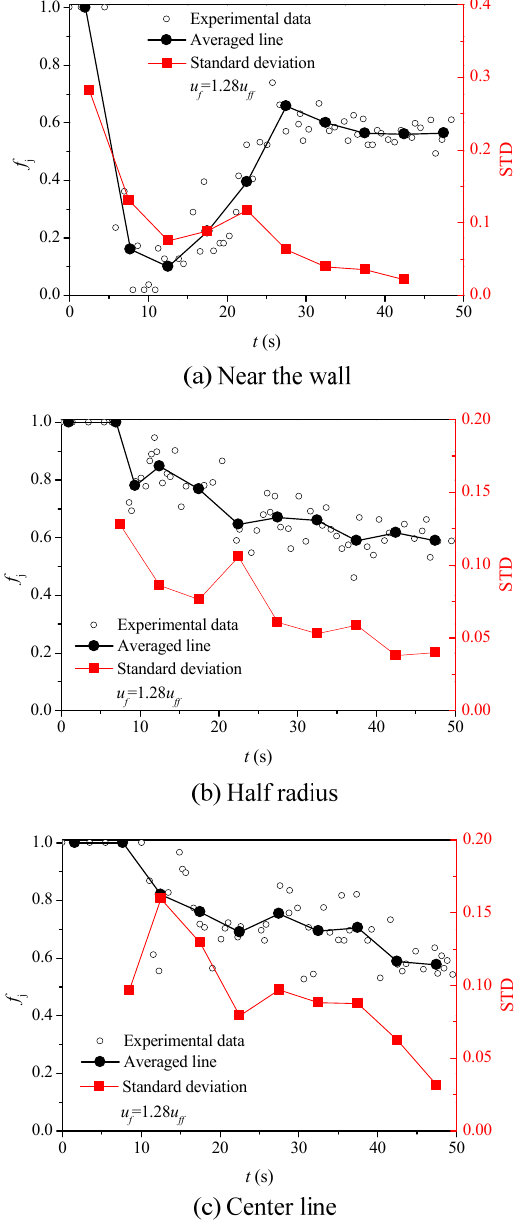
Figure 5. Variations of the micro mixing ratio and its standard deviation with time at different lateral positions when the bed height is 0.25 H 0 . ( a ) Near the wall. ( b ) Half radius. ( c ) Center